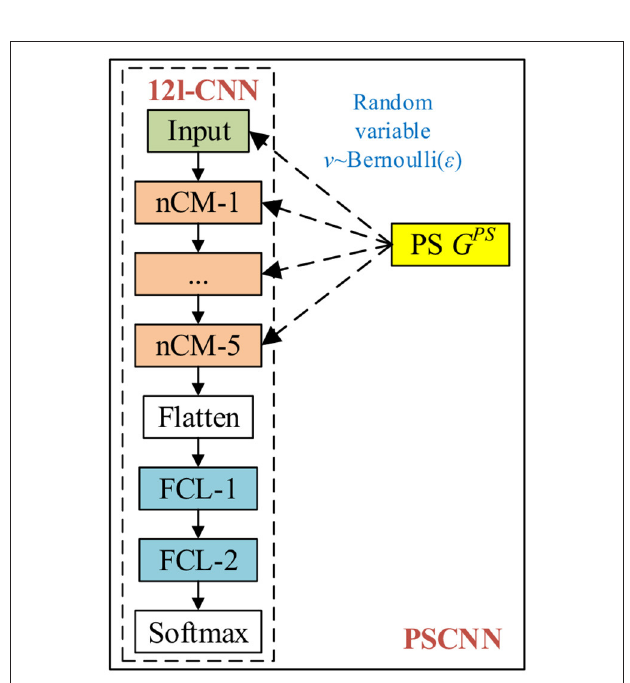
FIGURE 9 | Diagram of PatchShuffle Convolutional Neural Network (PSCNN).